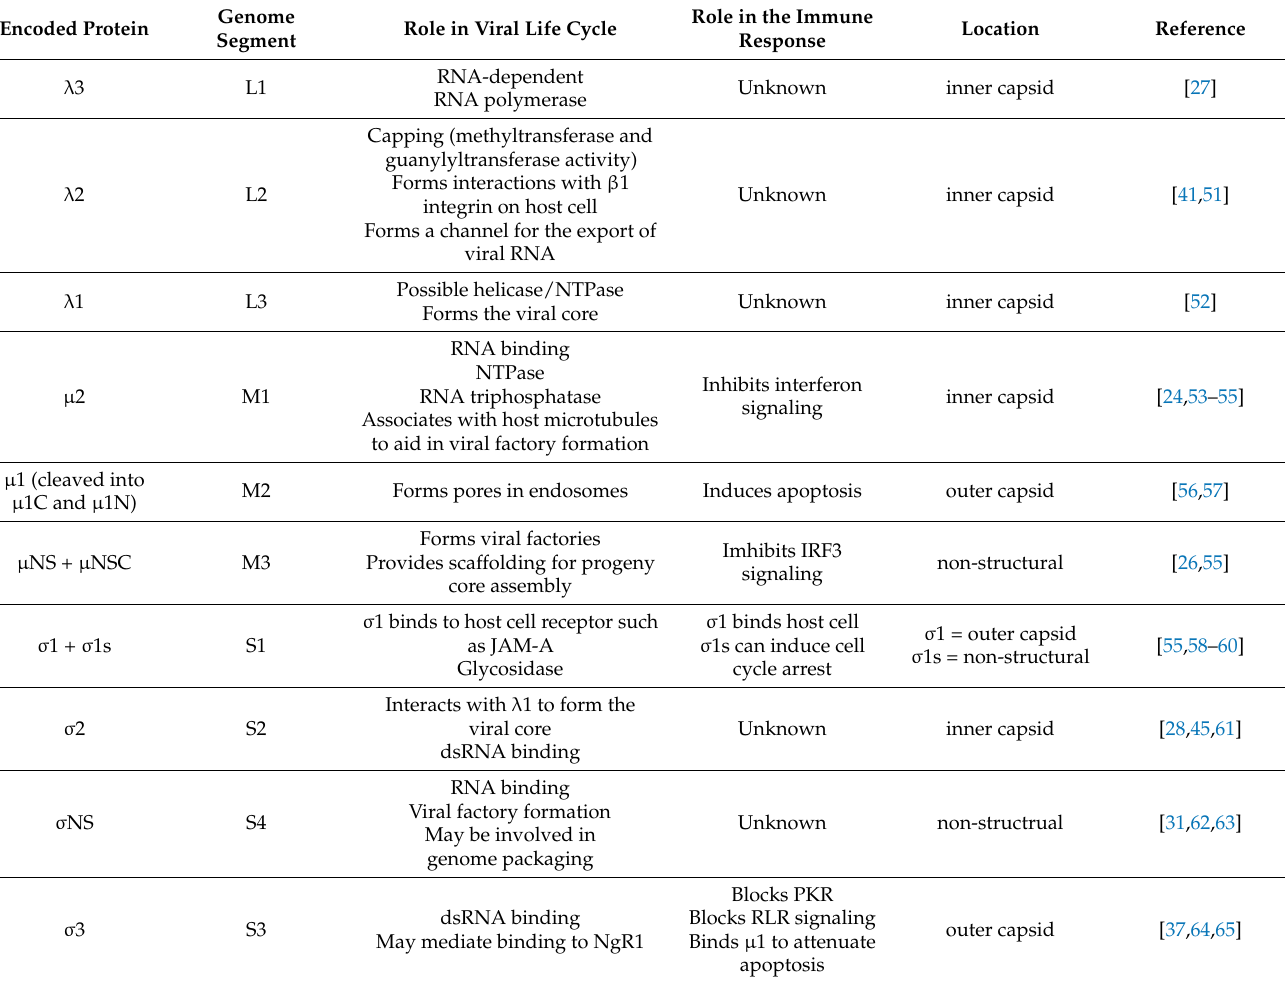
Table 1. ReoV proteins and their known functions. This table lists all proteins encoded by the ReoV genome, the segment which encodes each protein, the known functions of the proteins, and their location in the